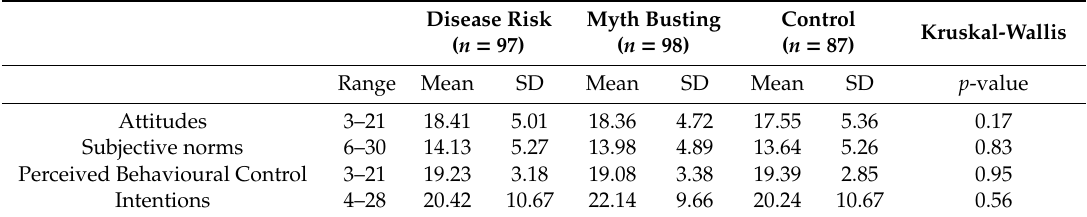
Table 3. Mean Scores for the Theory of Planned Behaviour variables across the three intervention conditions ( n =